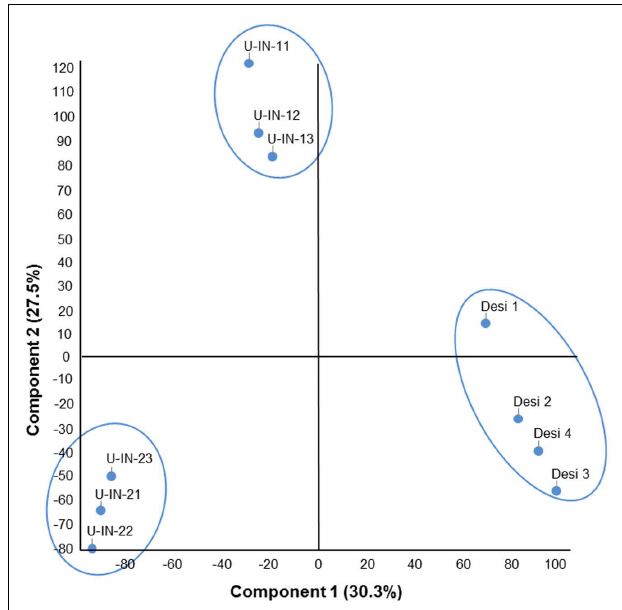
FIGURE 1 | Principle component analysis (PCA) of transcription data. Replicates illustrating that the individual replicates of each genotype